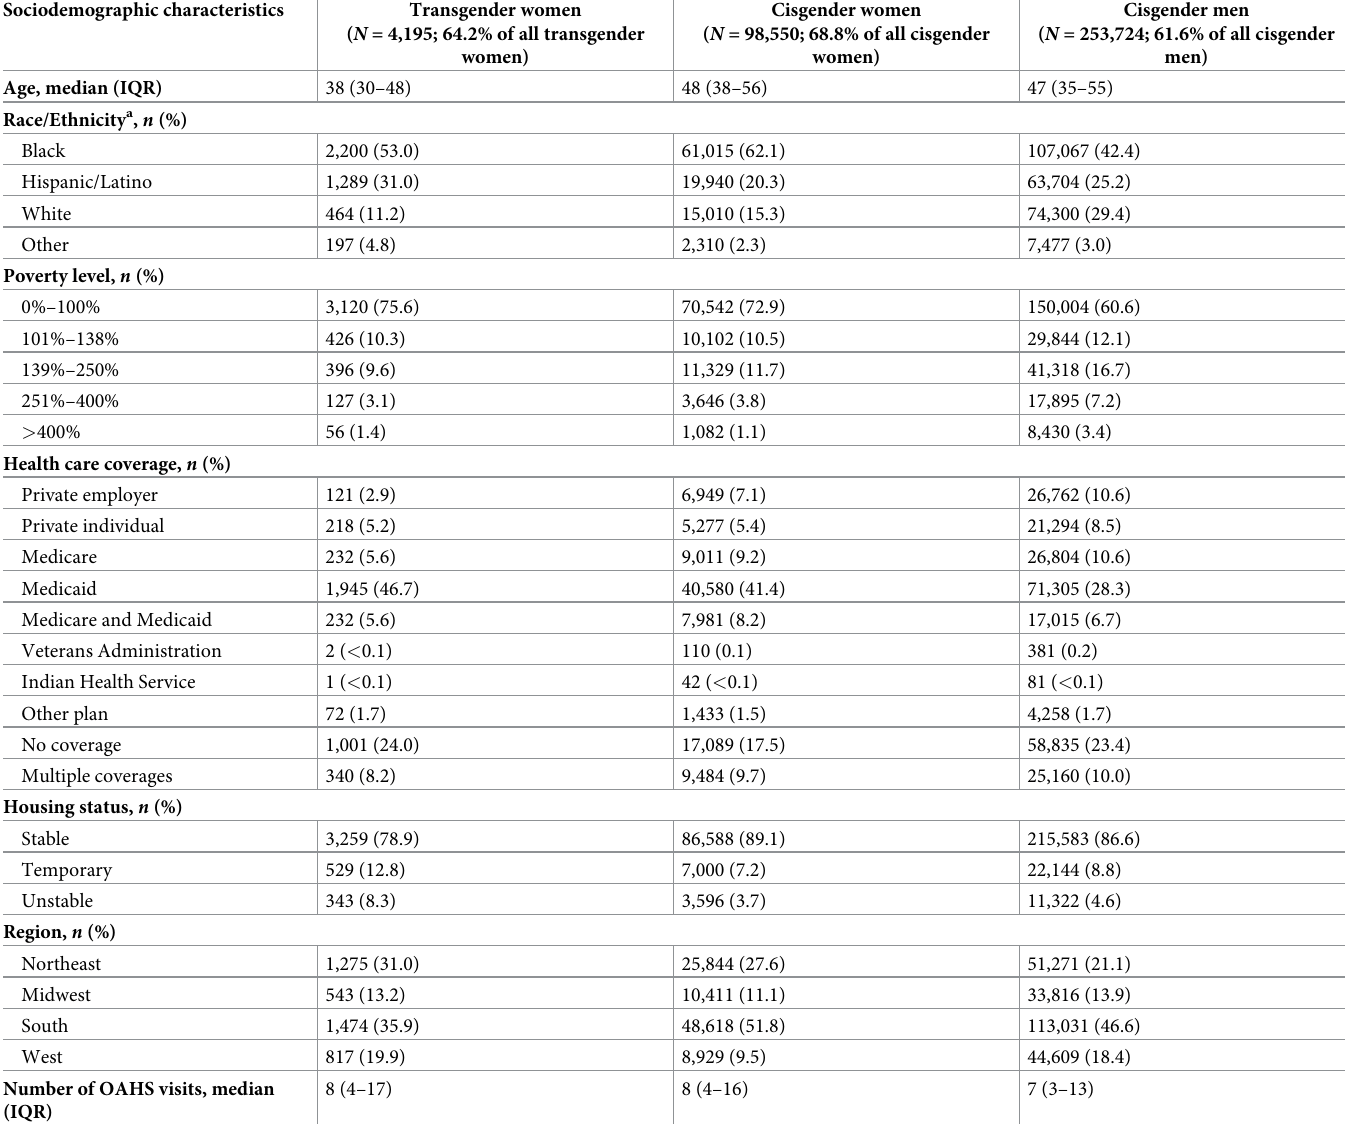
Table 2. Transgender women, cisgender women, and cisgender men served by the HRSA RWHAP who received OAHS, 2016. Sociodemographic